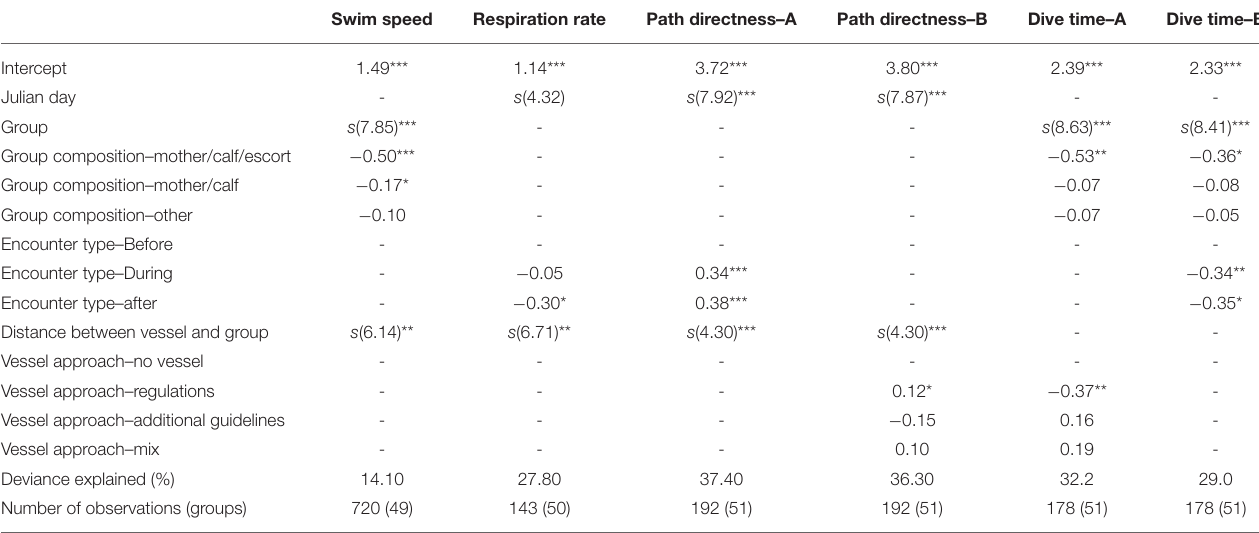
TABLE 2 | Summary of top GAM models showing the relationship between humpback whale behavior and vessel activities, where rows represent candidate explanatory variables and columns represent response